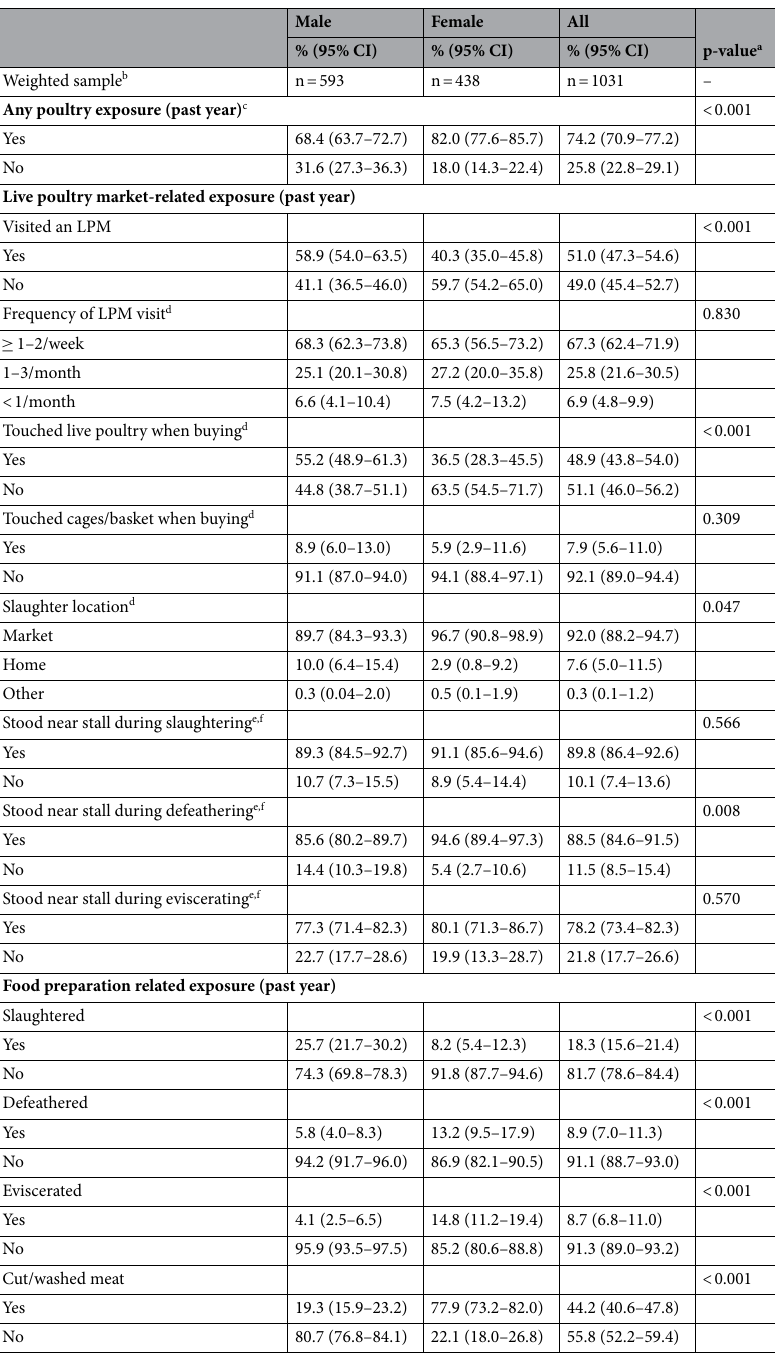
Table 2. Exposure to live poultry in markets and during food preparation in the past year, by sex, Dhaka City Corporation, Bangladesh. CI confidence interval, LPM live poultry market. a P-value obtained from chi-square test comparing males and females. b Sample weighted by age, sex and education to the Dhaka City Corporation demographic profile of the 2011 Bangladesh census. c Any poultry exposure is a combined outcome variable which includes both live poultry market-related and/or food preparation related exposures in the past year. d Weighted denominator includes those who report visiting an LPM, n = 525. e Weighted denominator includes those who report slaughter location as market, n = 454. f Stood near defined as within 1 m, allowing for buyers to directly observe poultry